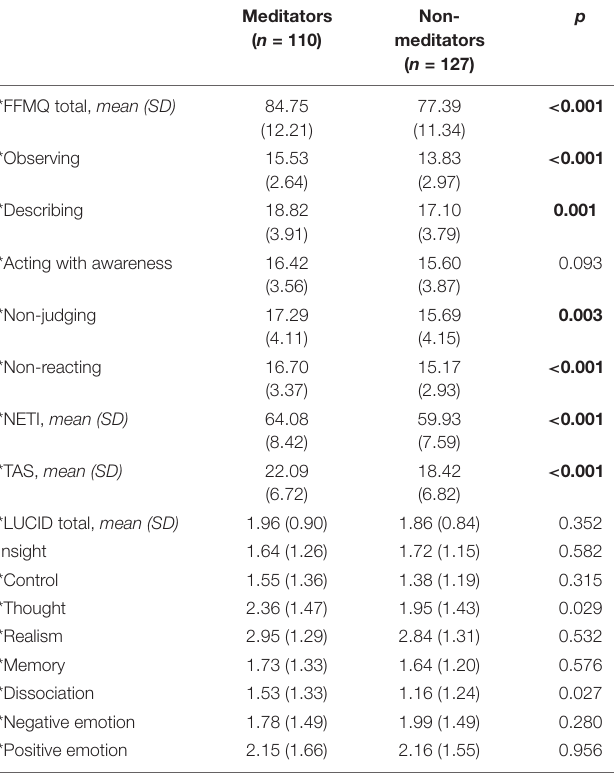
TABLE 2 | Between-group differences (i.e., meditators vs. non-meditators) in the study variables.